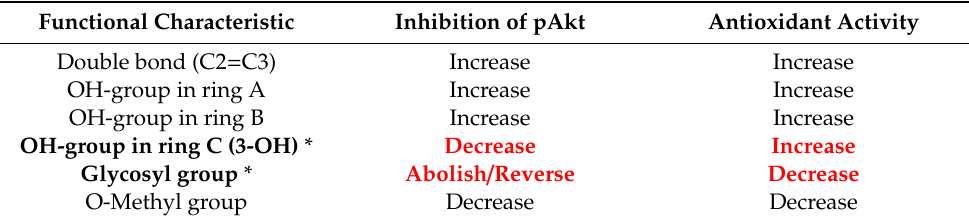
Table 3. Comparison of the proposed structure-activity features regarding inhibitory e ff ects on Akt-phosphorylation (pAkt) determined in the present study with the antioxidant properties of polyphenols